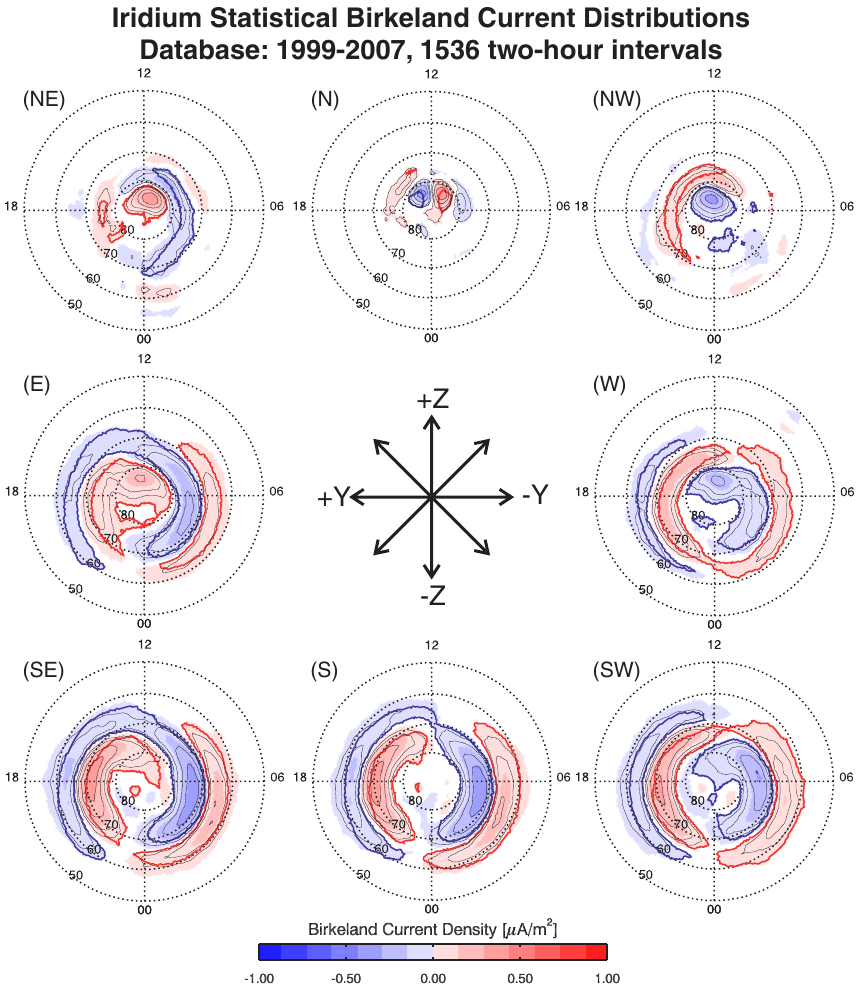
Fig. 3. Statistical distributions of the large-scale upward (red) and downward (blue) Birkeland currents obtained from 1536 two-hour distributions observed by Iridium. The IMF direction projected in the Y-Z GSM plane for each distribution is indicated by the arrows in the center. Only currents above the 2 σ confidence threshold are shown. The red and blue contours indicate the overlap of the large-scale upward and downward current regions, respectively, with those obtained from the